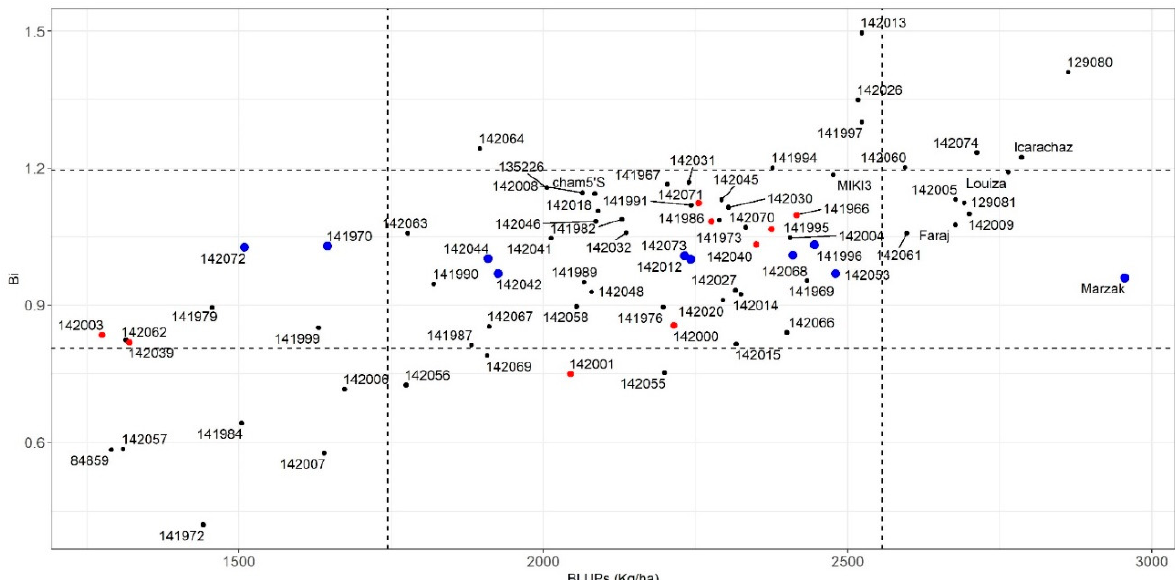
Figure 4. Plot of Best linear unbiased predictions (BLUPs) for grain yield plotted against the regression coefficient (Bi). Each point represents a single breeding line. Vertical and horizontal lines represents the grand mean ± 1 SD of BLUPs and Bi, respectively. Blue color represents the first ranked breeding lines according to Bi, red color represents the first ranked breeding lines according to the squared deviation from the regression (S²di). Some labels were repelled using black arrows to avoid overlapping.